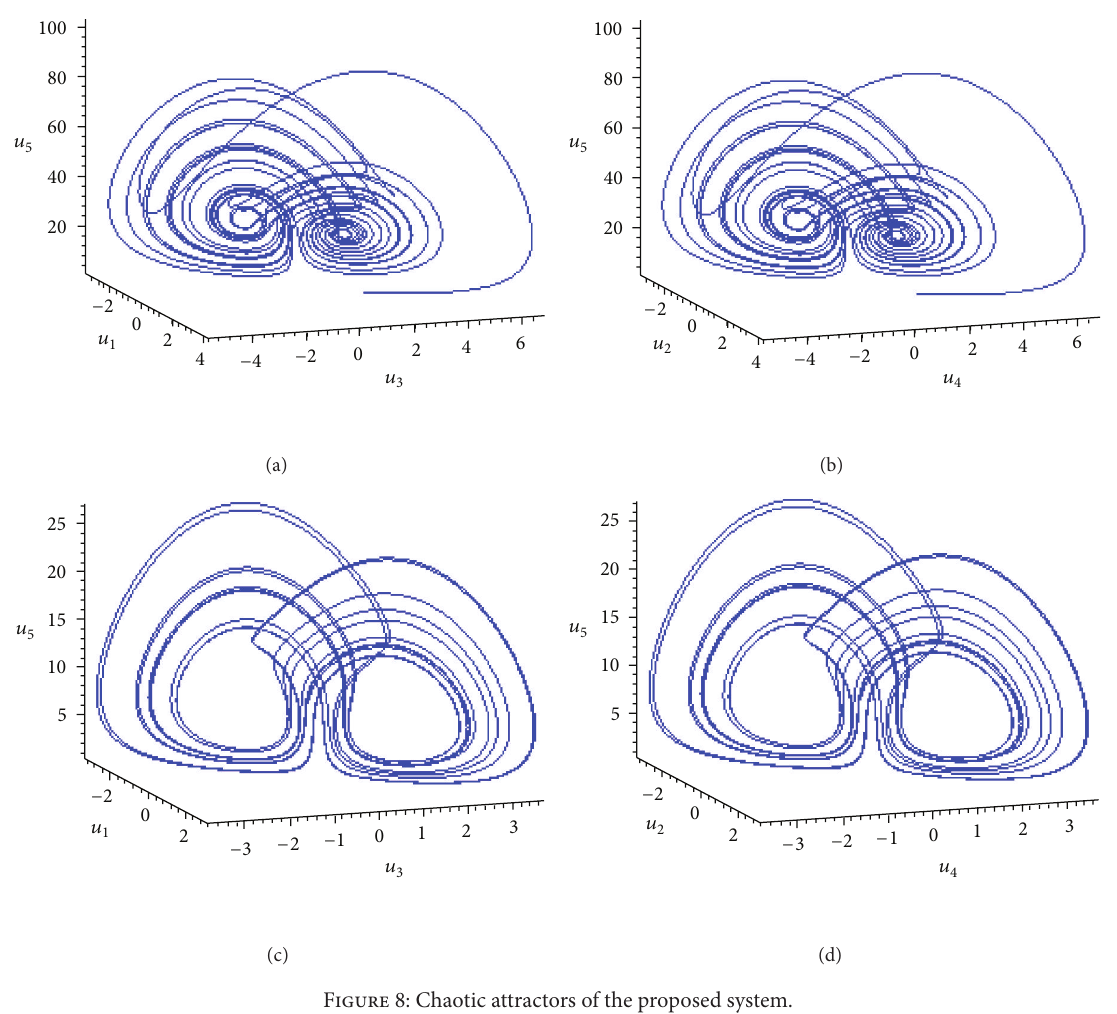
Figure 8: Chaotic attractors of the proposed